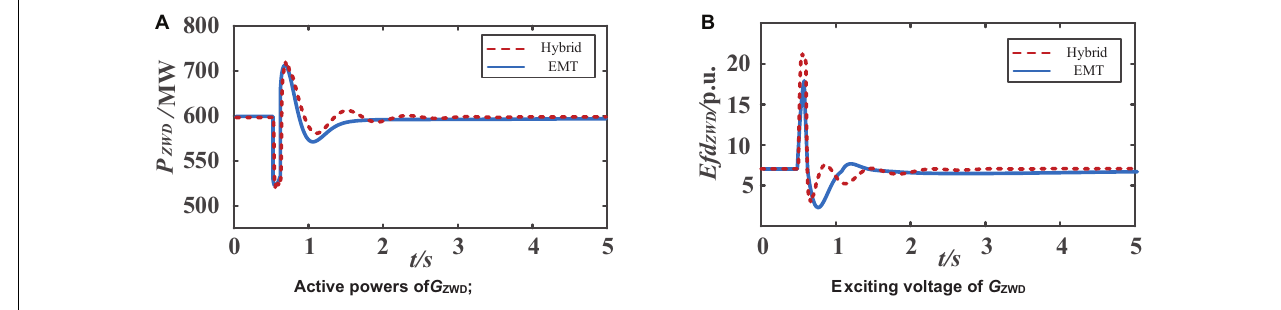
FIGURE 8 | Dynamic characteristics of generators in the TS simulation; (A) Active powers of G ZWD ; (B) Exciting voltage of G ZWD .